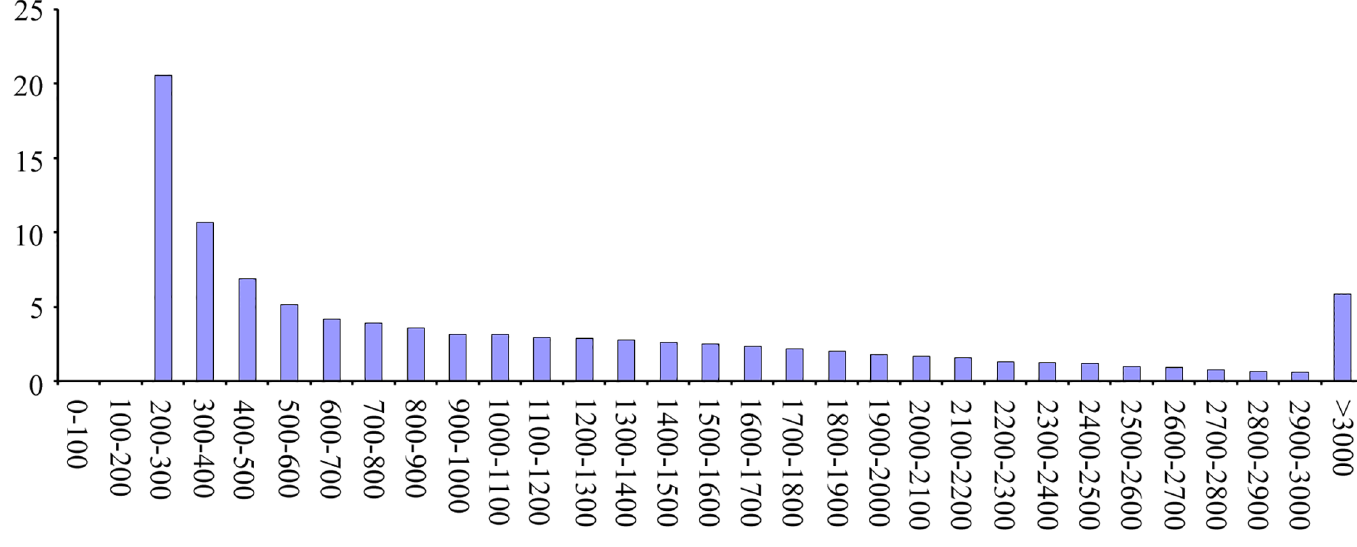
Fig 1. Frequency distribution of